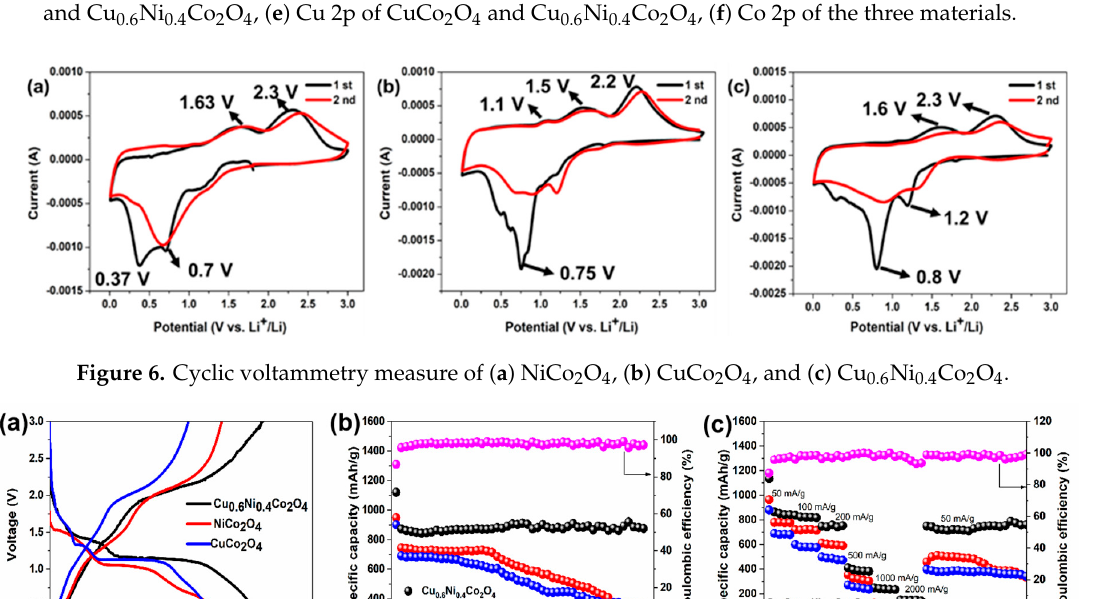
Figure 5. XPS spectra of ( a ) NiCo 2 O 4 , ( b ) CuCo 2 O 4 , ( c ) Cu 0.6 Ni 0.4 Co 2 O 4 and ( d ) Ni 2p of NiCo 2 O 4 and Cu 0.6 Ni 0.4 Co 2 O 4 , ( e ) Cu 2p of CuCo 2 O 4 and Cu 0.6 Ni 0.4 Co 2 O 4 , ( f ) Co 2p of the three materials.